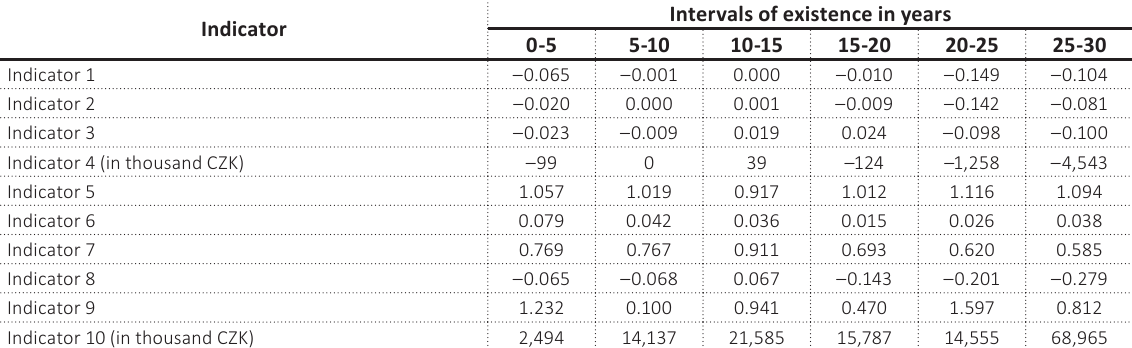
Table 2. Median of selected financial